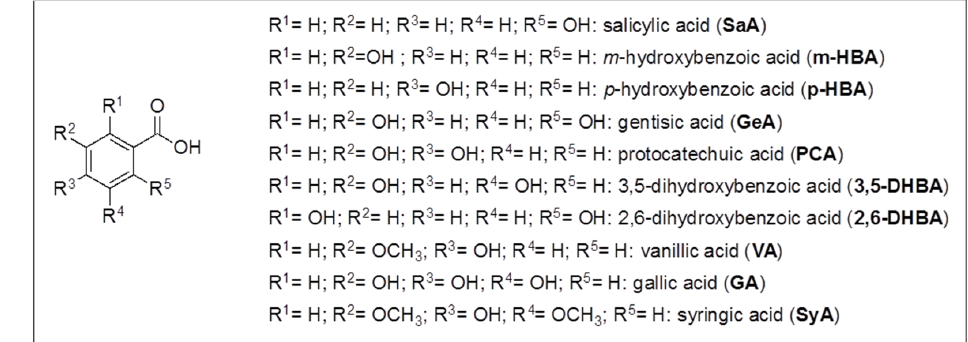
Figure 3. AR3 herbal tea, diluted 1:10 with mobile phase, ESI-SIR channels at m/z 174 ( a ), 190 ( b ), 215 ( c ) and 231 ( d ), corresponding to the ion [M-H] − of IAA ( a ), 5-HIAA ( b ), T β C-3-COOH ( c ) and 6-HT β C-3-COOH ( d ).